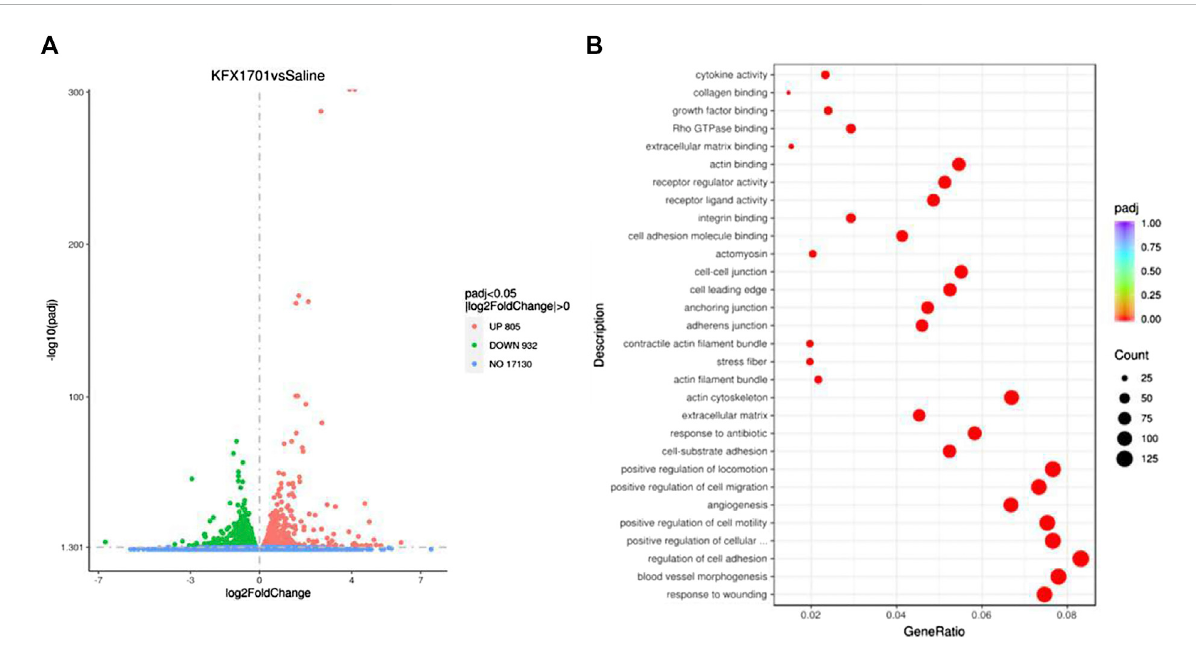
FIGURE 2 Transcriptomics sequencing analysis of Kangfuxin ’ s effect on cutaneous epithelial cells. (A) Volcano plot. (B) Kyoto Encyclopedia of Genes and Genomes (KEGG) enrichment